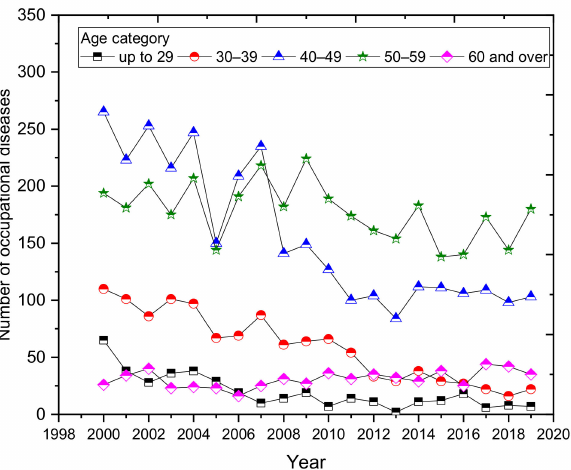
Figure 9. Development of the number of occupational diseases by age category